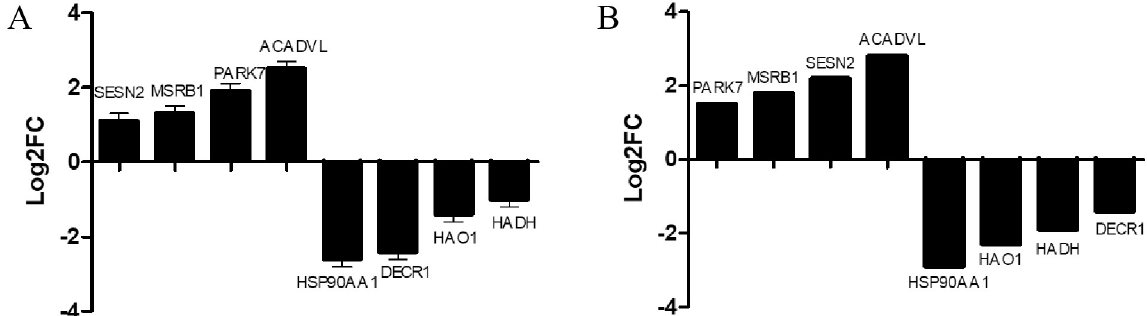
Fig 3. RNA-seq and qRT-PCR verification results of 8 DEGs in liver tissue. (A) qRT-PCR verification results of 8 DEGs in liver tissue. (B) RNA-seq results of 8 DEGs in liver tissue. Those on the X-axis are up-regulated genes, and those on the X-axis are down-regulated genes. Data are the means ± SD of three parallel experiments.